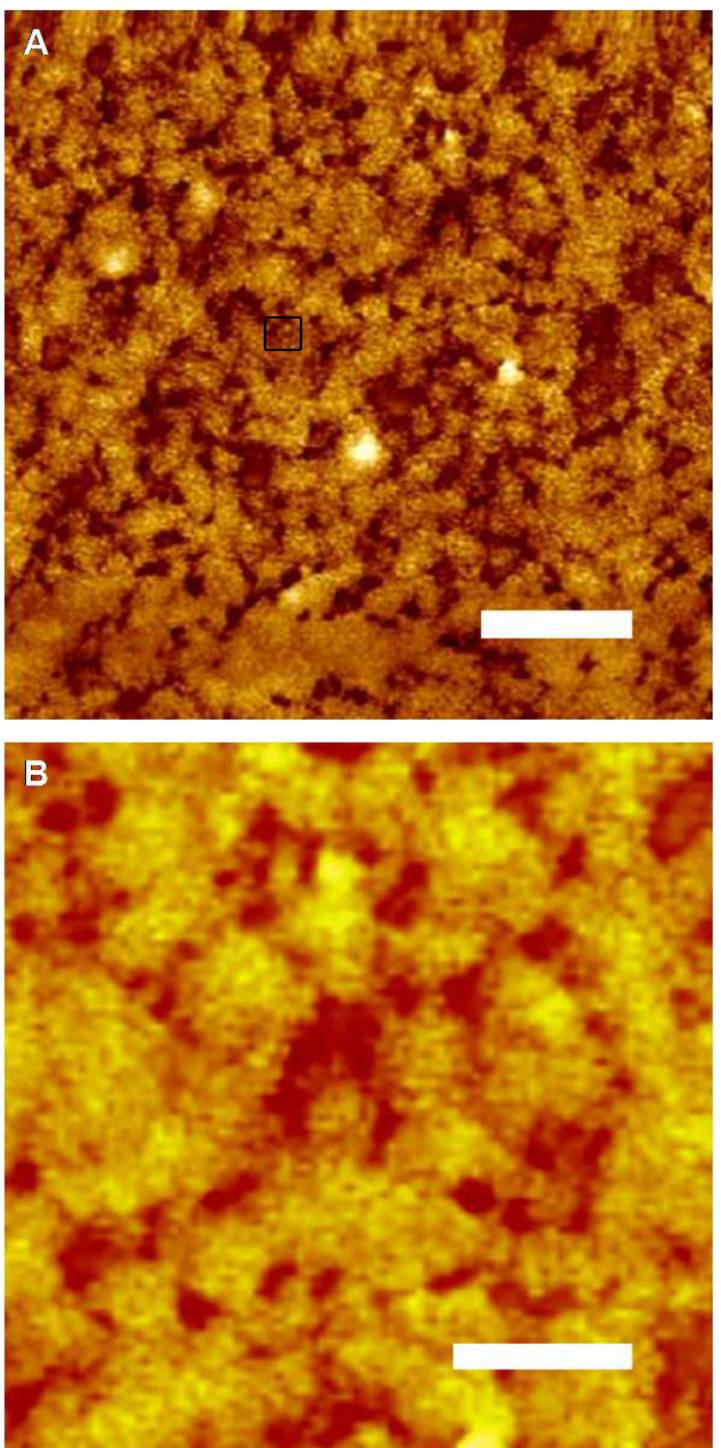
Figure 2. Atomic force microscopy micrographs of spherical pDNA-HCcp3 particles with a bp to dimer ratio of 20 to 1. ( B ) The magnified micrograph of selected area in ( A ). The The pDNA is the pUC18 plasmid. Scale bar in panel ( A) 1 µm; Scale bar in panel ( B) 200